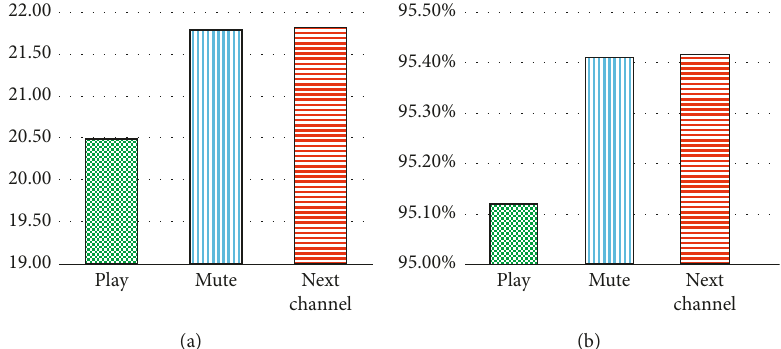
Figure 17: Performance comparisons in terms of (a) DCr and (b) SSr for play , mute , and channel change buttons, respectively.